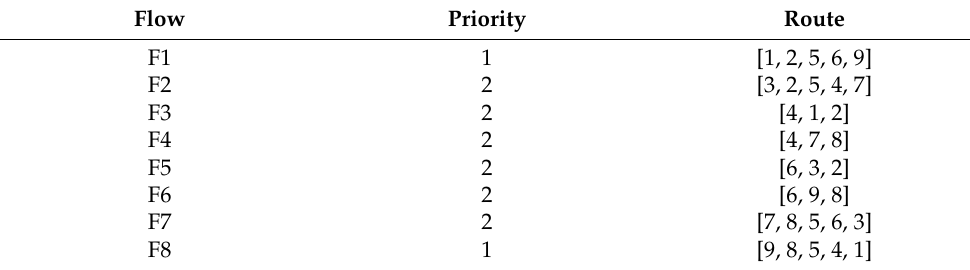
Figure 10. The structure of network topology, adapted from [26], with permission from IEEE, 2022. We implemented a mesh-type network topology with nine nodes to verify that the DDQN scheduler works properly even when expanding the network size. Table 7. Flows in network topology.